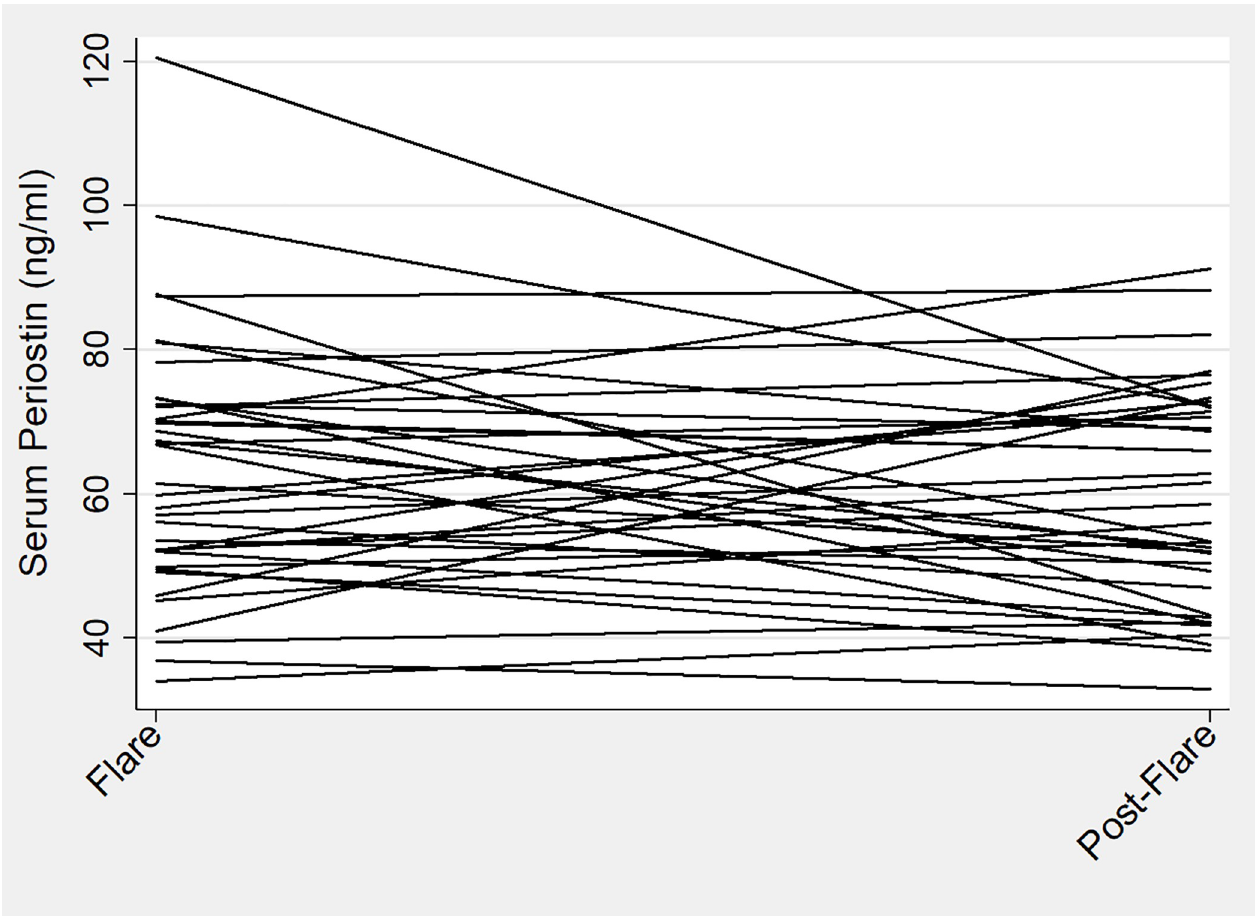
Fig 2. Individual participant periostin levels at flare and post-flare visit. This spaghetti plot depicts individual change in periostin level from flare to post- flare visit with a single line representing a single individual. Overall, no significant differences were observed in periostin level between flare and post-flare visit.